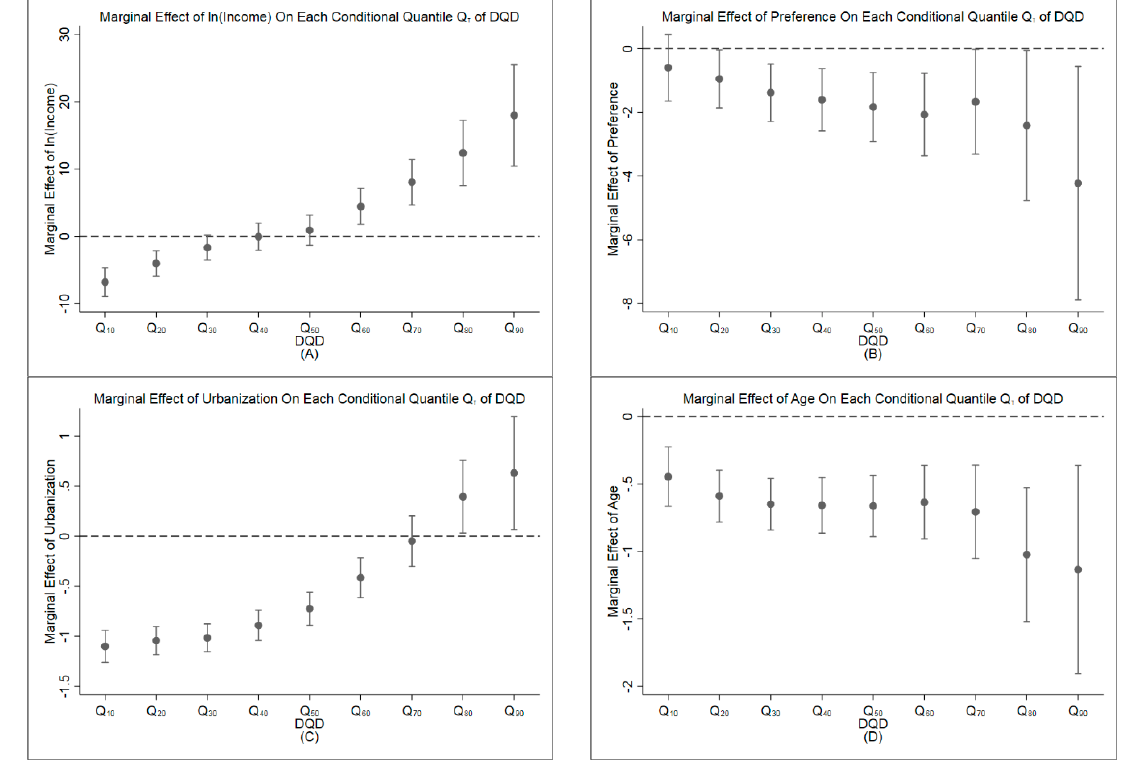
Figure 5. Marginal effect of co-variants on each DQD quantile with 95% CI. ( A ) The marginal effects of income on each DQD quantile; ( B ) the marginal effects of healthy food preference on each DQD quantile; ( C ) the marginal effects of urbanization on each DQD quantile; ( D ) the marginal effects of age on each DQD quantile.